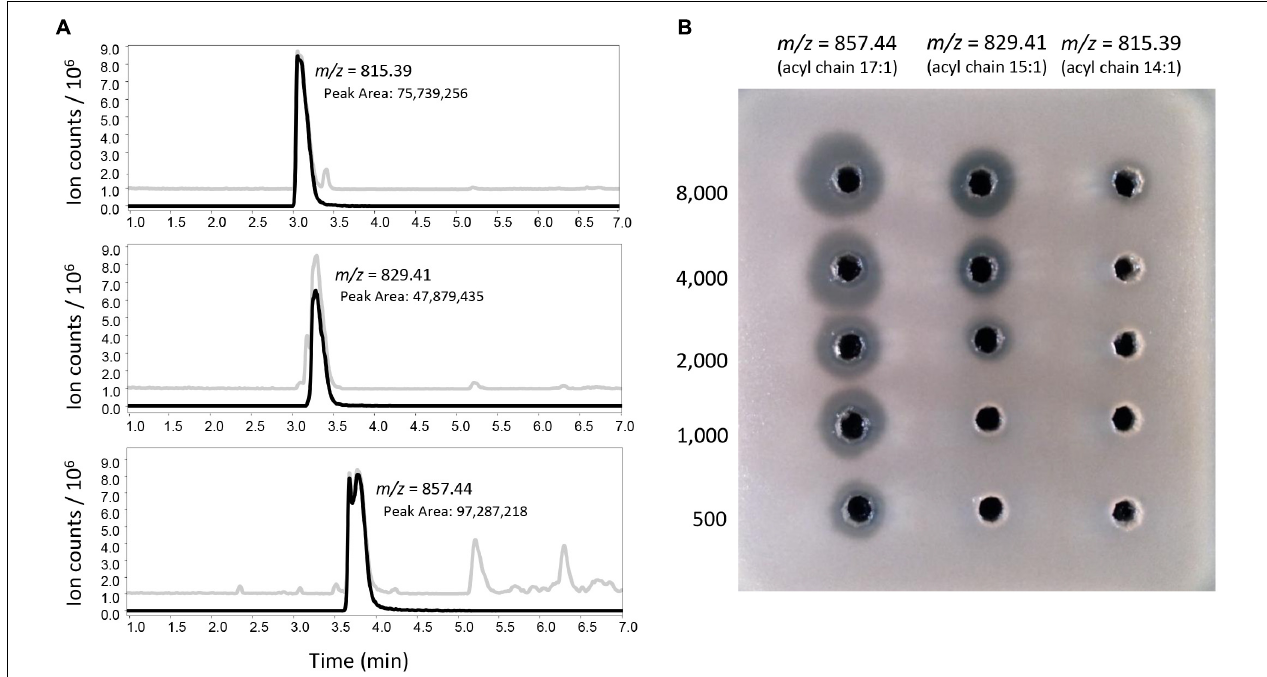
FIGURE 6 | Antifungal activity of different isolated tunicamycins. (A) LC-MS analysis (negative mode) of tunicamycins purified from a commercial tunicamycin complex. Gray lines represent the base peak chromatogram for each sample. Black lines represent the extracted ion chromatogram corresponding to the mass of each tunicamycin congener. (B) Bioassays showing the relative antifungal activity of the purified tunicamycins. Each column corresponds to serial twofold dilutions of each purified tunicamycin. Concentrations are indicated in peak area units/ µ l, starting from 8,000 for the starting sample in each